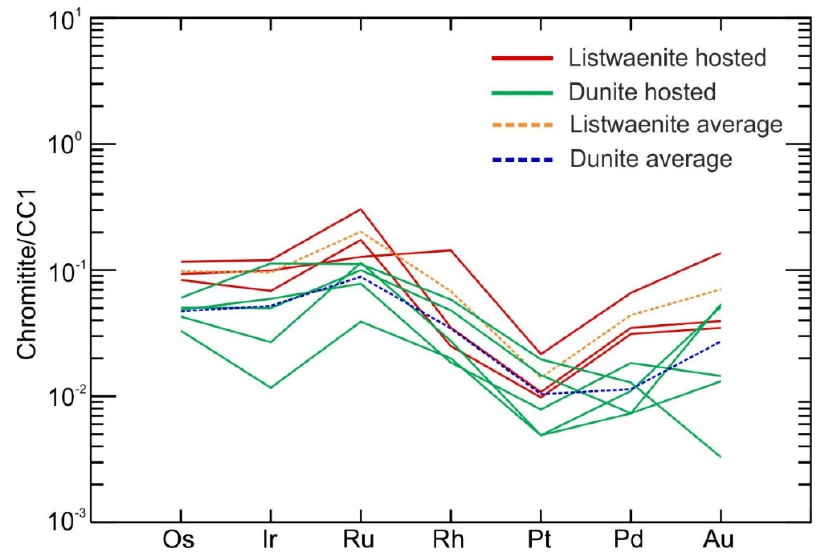
Figure 9. Chondrite-normalized PGE concentrations, after [39], of chromitites hosted within unaltered dunites [22] and listwaenites (reported in this study), the average compositions of each group are also presented.